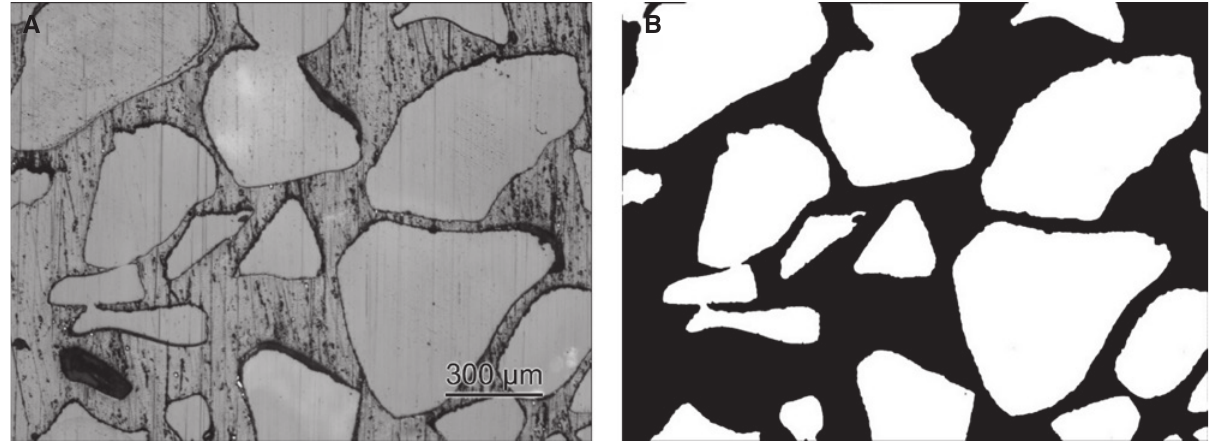
Figure 1: Representative sintered glass micrographs analyzed using Image J: (A) original optical micrograph and (B) processed image used for porosity measurement.